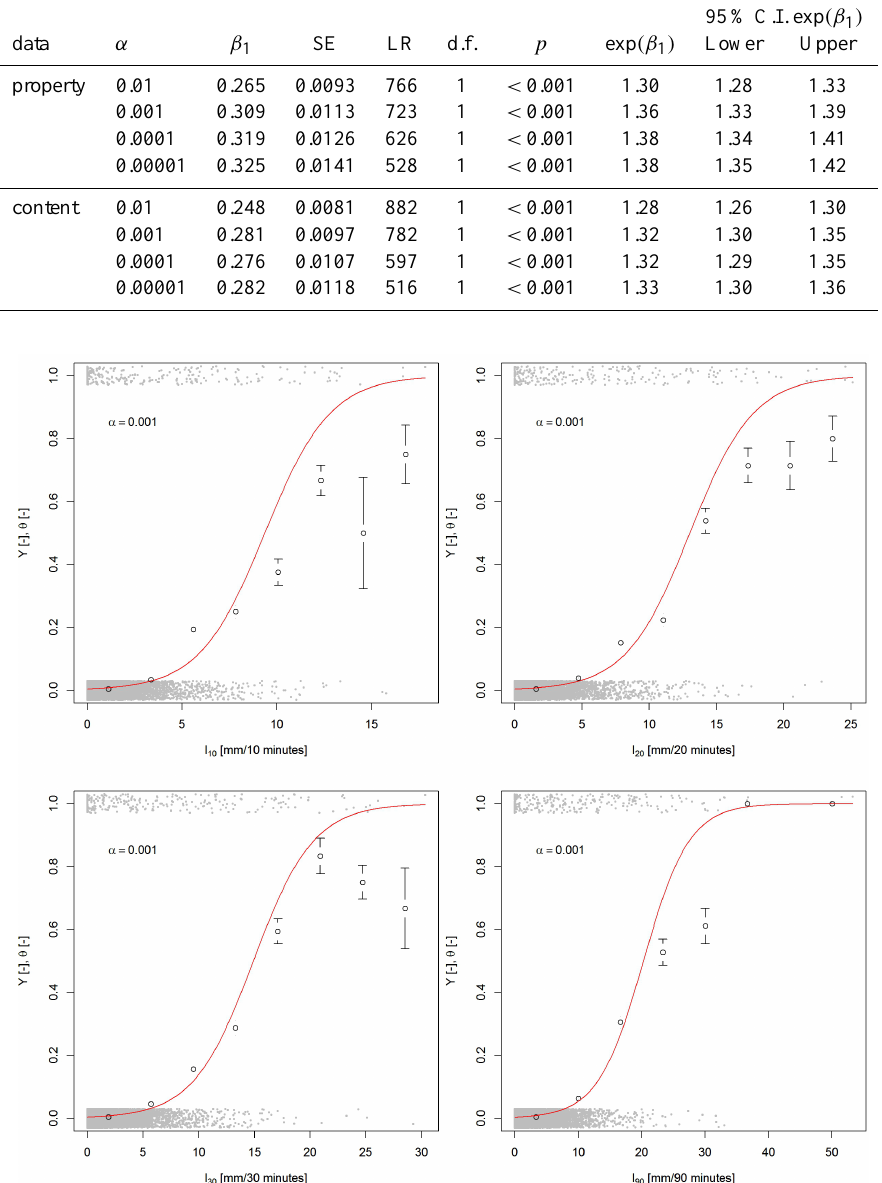
Table 4. Logistic regression results for model fits on property and content data. The results are based on z = 60 min and a range of α levels. The regression coefficient β 1 has units in h mm − 1 .